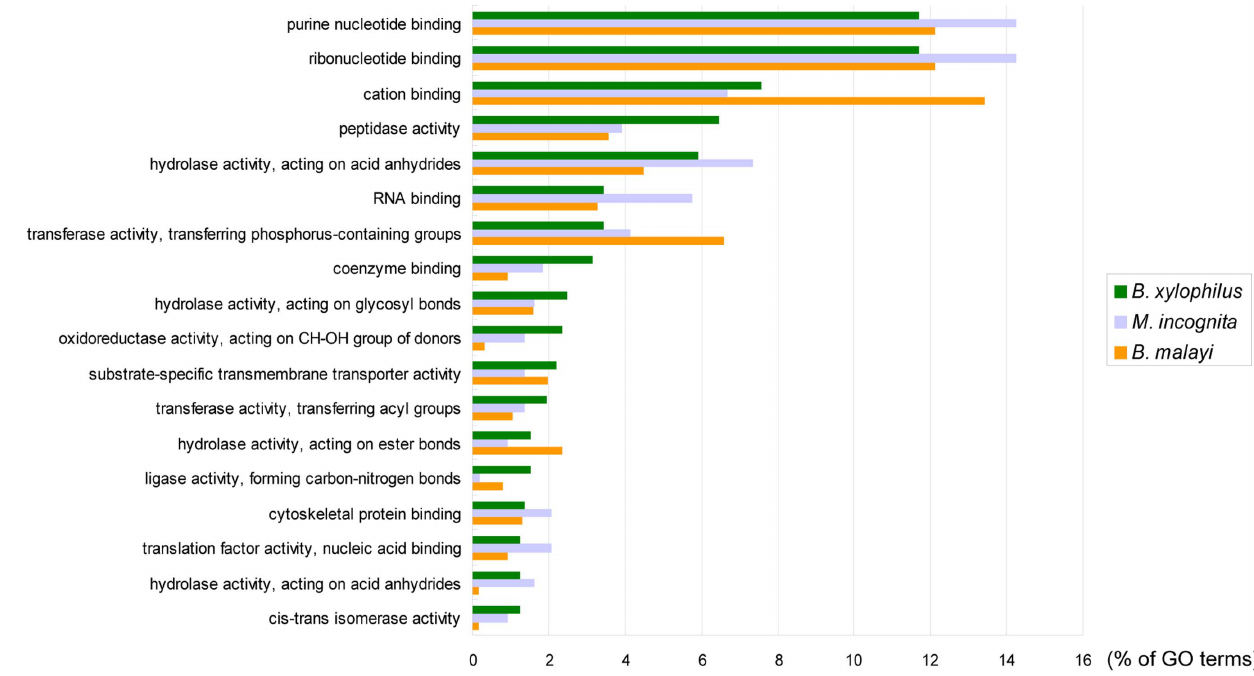
Figure 4. Distribution of molecular functions in Gene Ontology terms (Level 4) in the nematode secretomes.